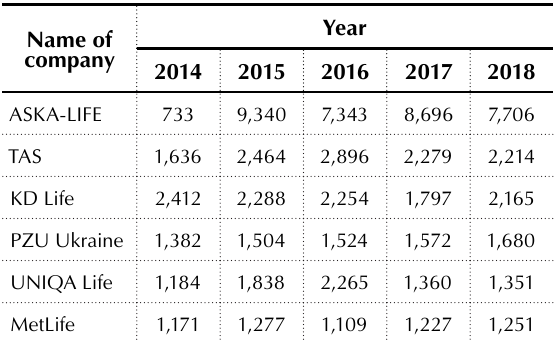
Table 2. Investment income from savings life insurance for one insured,